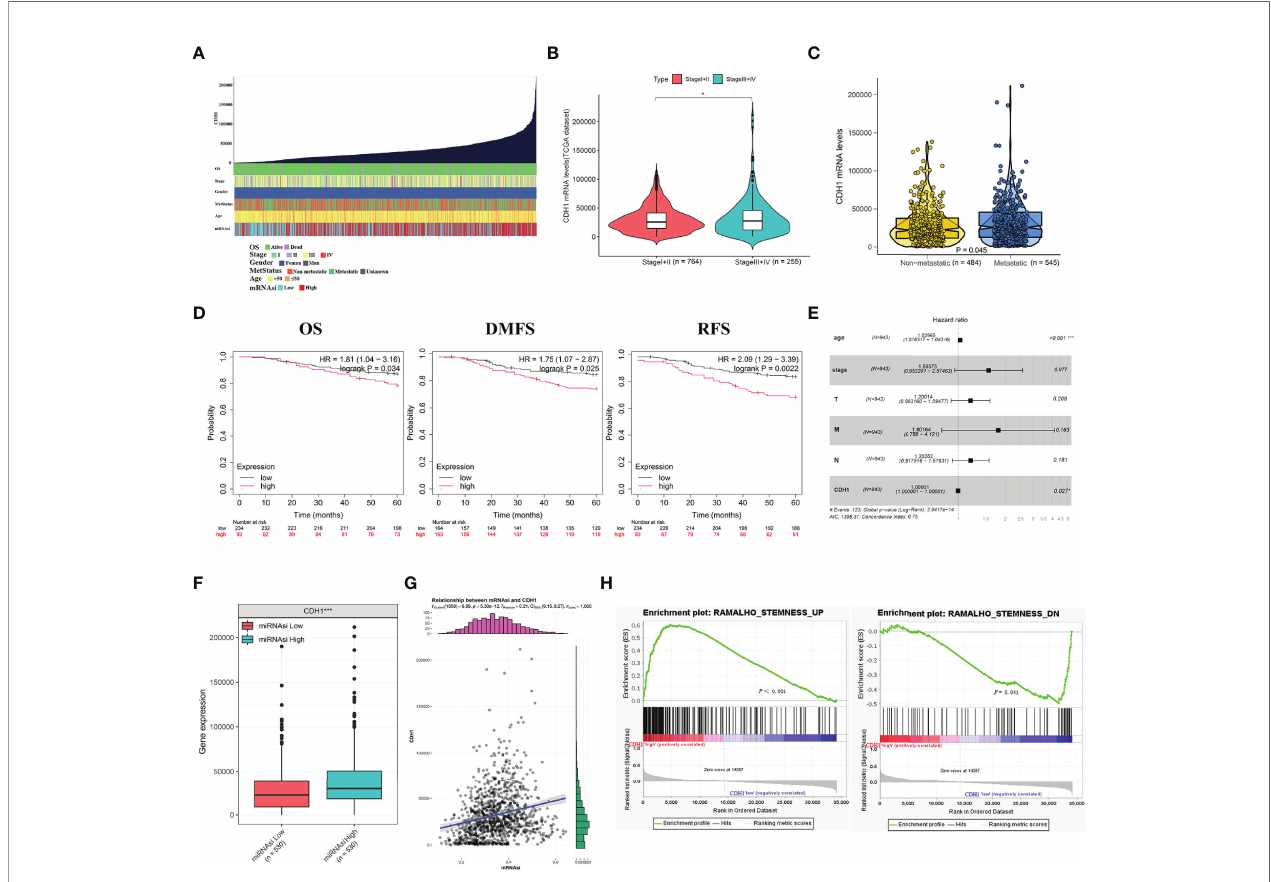
FIGURE 2 | CDH1 overexpression is intimately associated with the malignant progression of breast cancer. (A) An overview of the association between CDH1 and clinical features and stemness in BC. (B) Differential expressions of CDH1 in I+II and III+IV tumor stage in BC. (C) Differential expressions of CDH1 in non-metastatic and metastatic BC. (D) Elevated expression of CDH1 indicated poor clinical outcomes for BC patients were plotted from Kaplan-Meier plotter database. (E) Multivariate analysis of the correlation of CDH1 expression with OS among BC patients. (F) TCGA database analysis of CDH1 expression differences in BC mRNAsi high and low groups. (G) Correlation of CDH1 expression and mRNAsi in BC. (H) GSEA assessment of the enrichment score pro fi le of CDH1 expression in the stemness high and low groups. OS, overall survival; RFS, relapse-free survival; DMFS, distant metastasis-free survival. * P < 0.05; *** P <